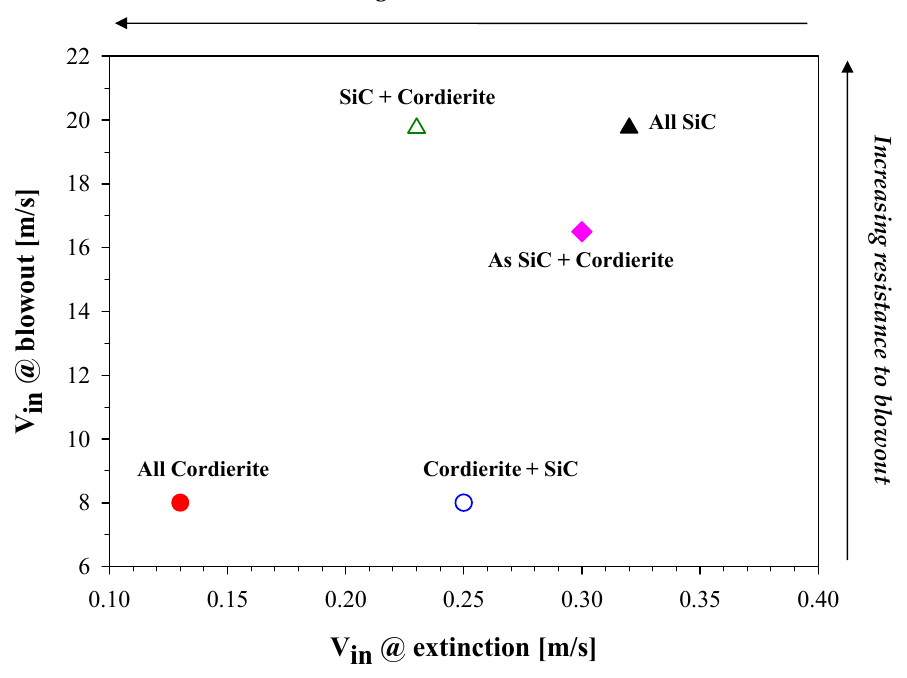
Figure 10. V in @ blowout as a function of V in @ extinction for different cases: All Cordierite; Cordierite + SiC; SiC + Cordierite; All SiC; As SiC + Cordierite.